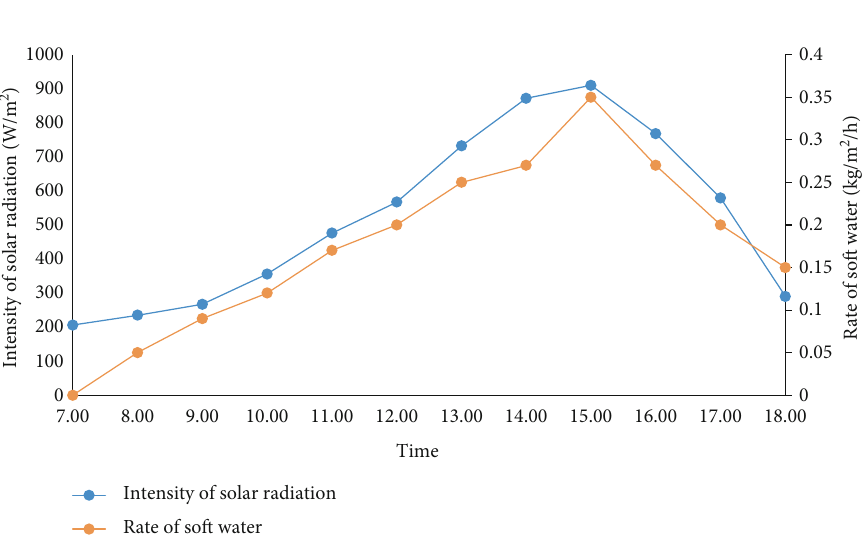
Figure 8: Rate of generation and solar intensity versus time (chrome mirror silver vinyl wrap on